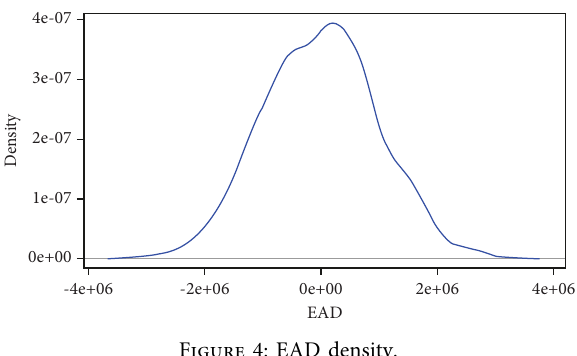
Figure 4: EAD density.